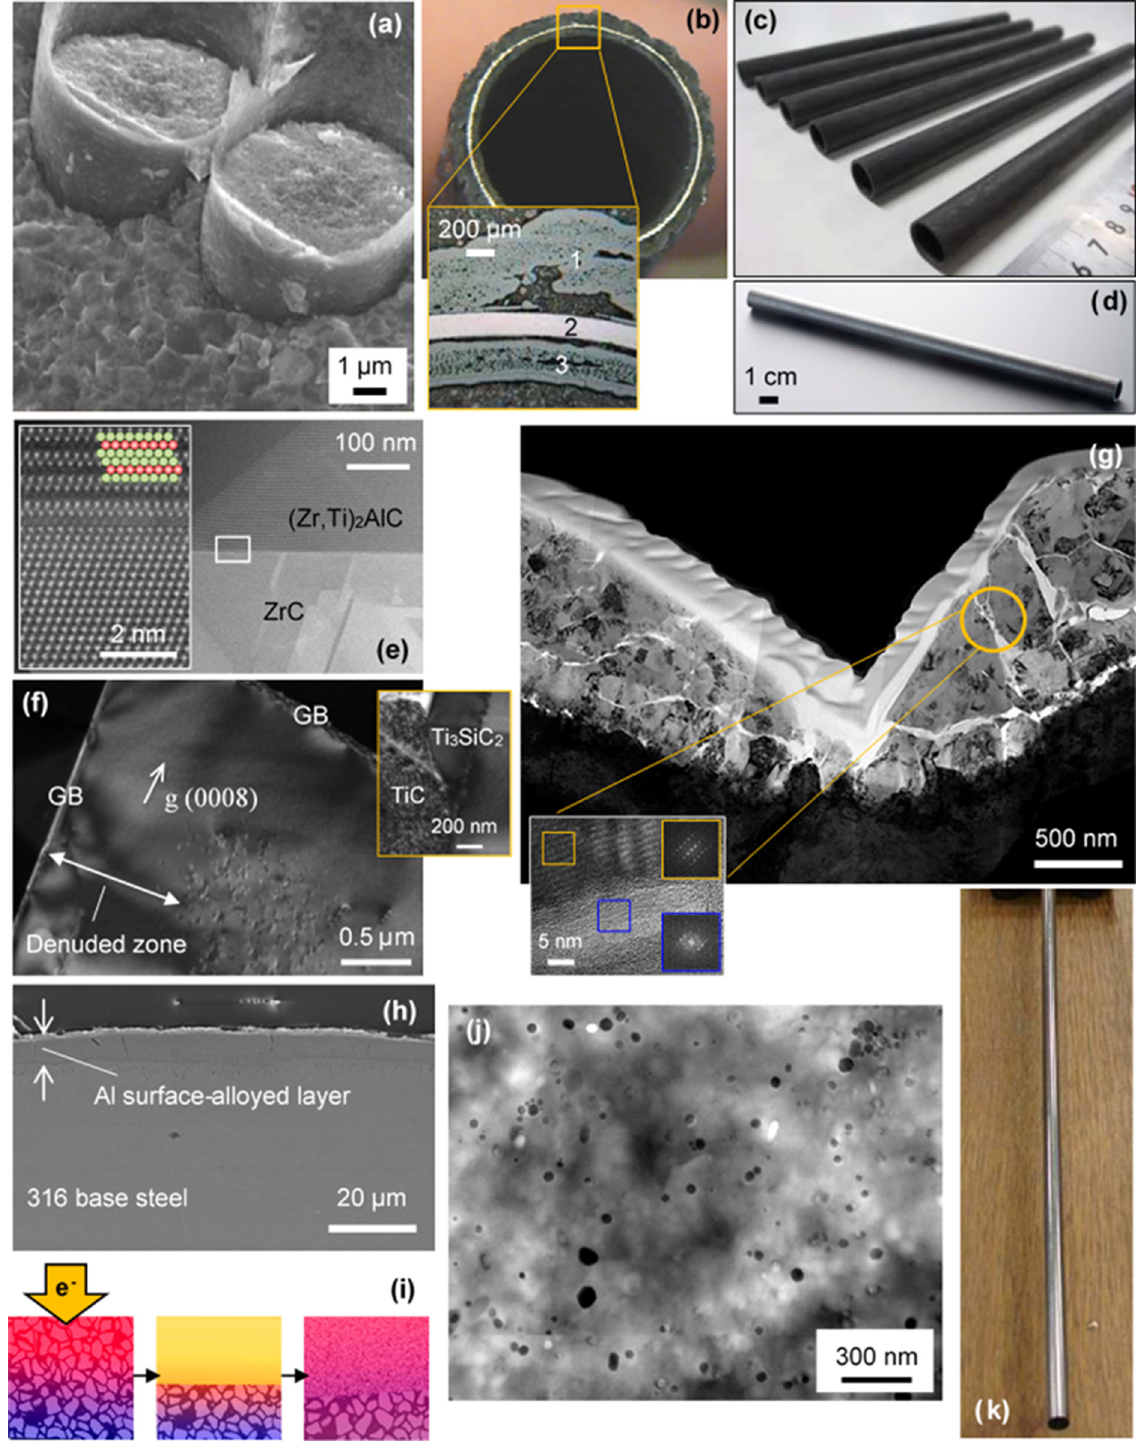
Fig. 1. (a – d) SiC/SiC composite clads: (a,c) DEMO-NITE SiC/SiC fracture surface and tubes; (b,d) CEA “ sandwich ” SiC/SiC cross- section and tube. (e) STEM image of a (Zr,Ti) 2 AlC MAX phase grain next to a ZrC “ impurity ” grain. The magni fi ed inset is a STEM image of the (Zr,Ti) 2 AlC/ZrC interface. (f) Neutron-irradiated Ti 3 SiC 2 ( ∼ 735 ° C, 3.4 dpa): defect-denuded zones are established next to grain boundaries (GBs) acting as potent defect “ sinks ” . The magni fi ed inset shows more damage in the “ impurity ” TiC grain than in Ti 3 SiC 2 . (g) TEM images of a nano-impacted, ion-irradiated (150 dpa) Al 2 O 3 coating: the crack-like features are fi lled with vitreous matter. (h) GESA Al surface-alloyed 316 L steel exposed to liquid LBE (10 000h, 600 ° C, C O ≈ 10 (cid:1) 6 mass%). (i) GESA surface modi fi cation by an intense pulsed electron beam: volumetric heating ! formation of a melt layer ! restructured surface layer. (j) TEM image of a Fe-20Cr-5Al-0.5Ti-0.5Y 2 O 3 alloy with nano-sized dispersoids. (k) Fe-14Cr ODS tube produced by